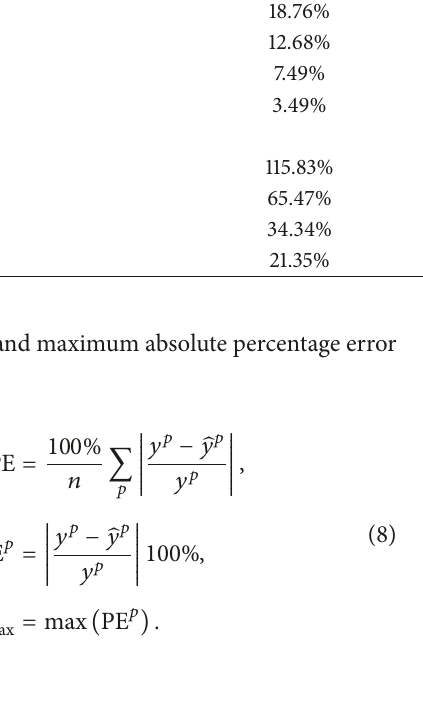
Table 9: MAPE and PE max errors calculated for the MLP